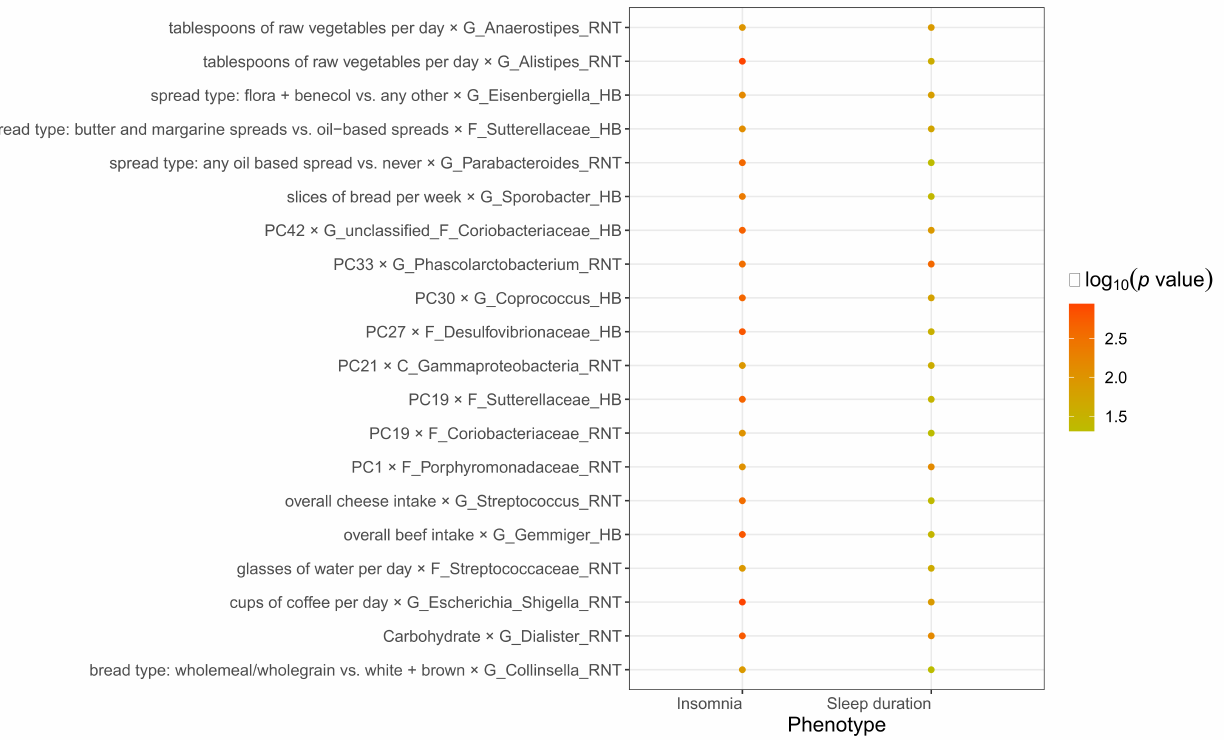
Figure 2. The top 20 common dietary habits/compositions-gut microbiota interactions shared by both insomnia and sleep